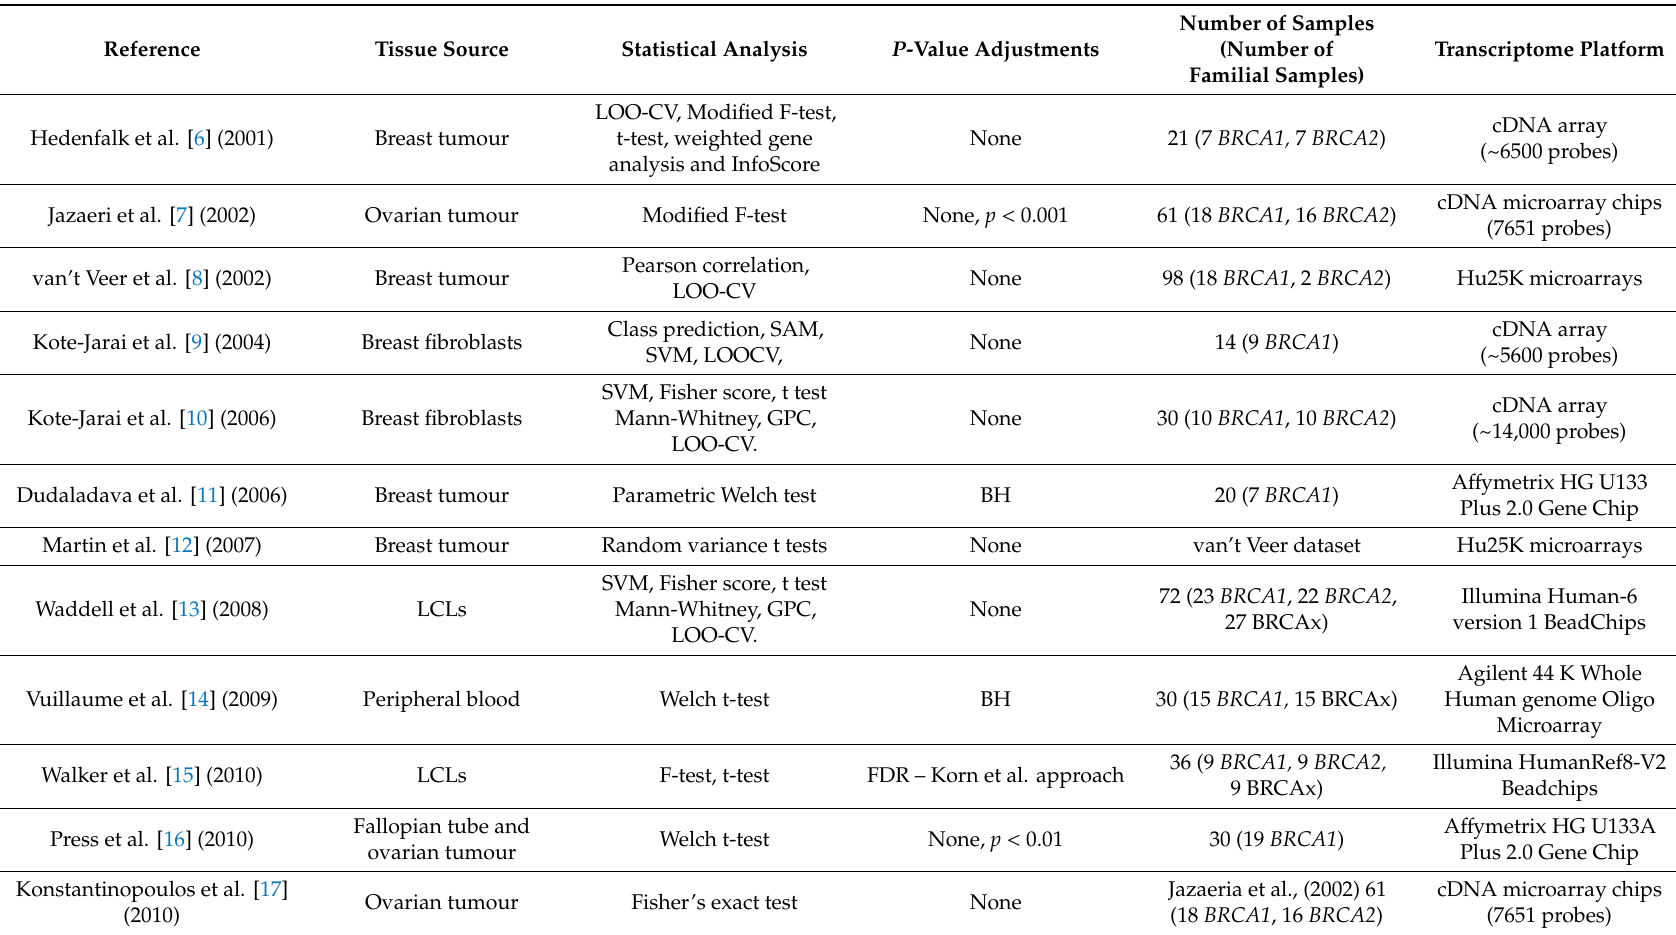
Table 1. Experimental approaches for gene expression studies of BRCA1 / 2 pathogenic variants BRCAx pathogenic variants or